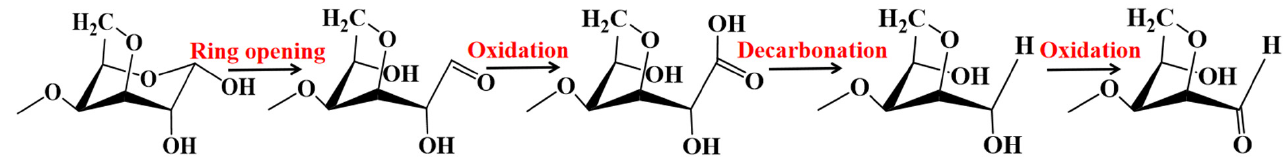
Figure 7. Proposed chemical structure change of AnGal during photocatalytic reaction.